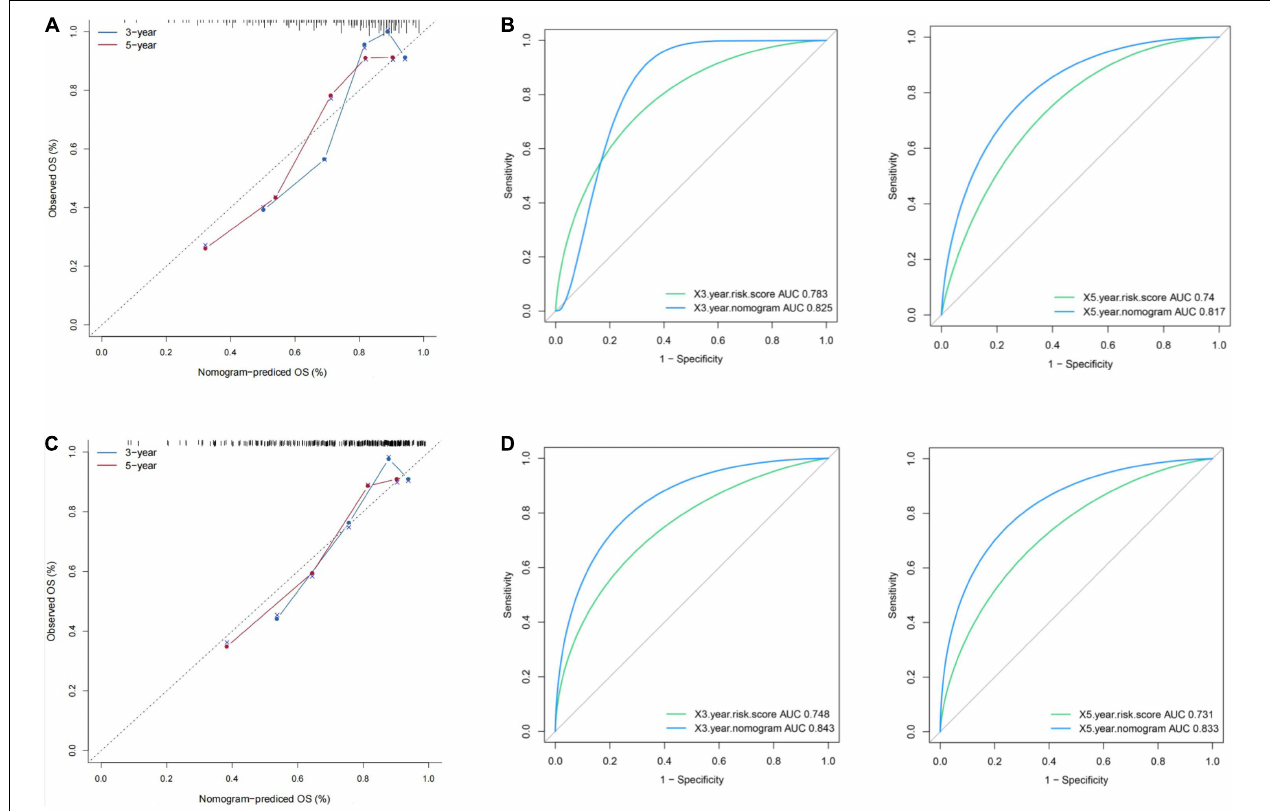
FIGURE 10 | Presentation of nomogram to predict survival probability and comparison of the predictive power between nomogram and risk score. Calibration plots and time-dependent ROC curves of the nomogram for predicting the probability of OS at 3 years and 5 years in the training set (A,B) and the validation set (C,D) . OS, overall survival; ROC, receiver operating